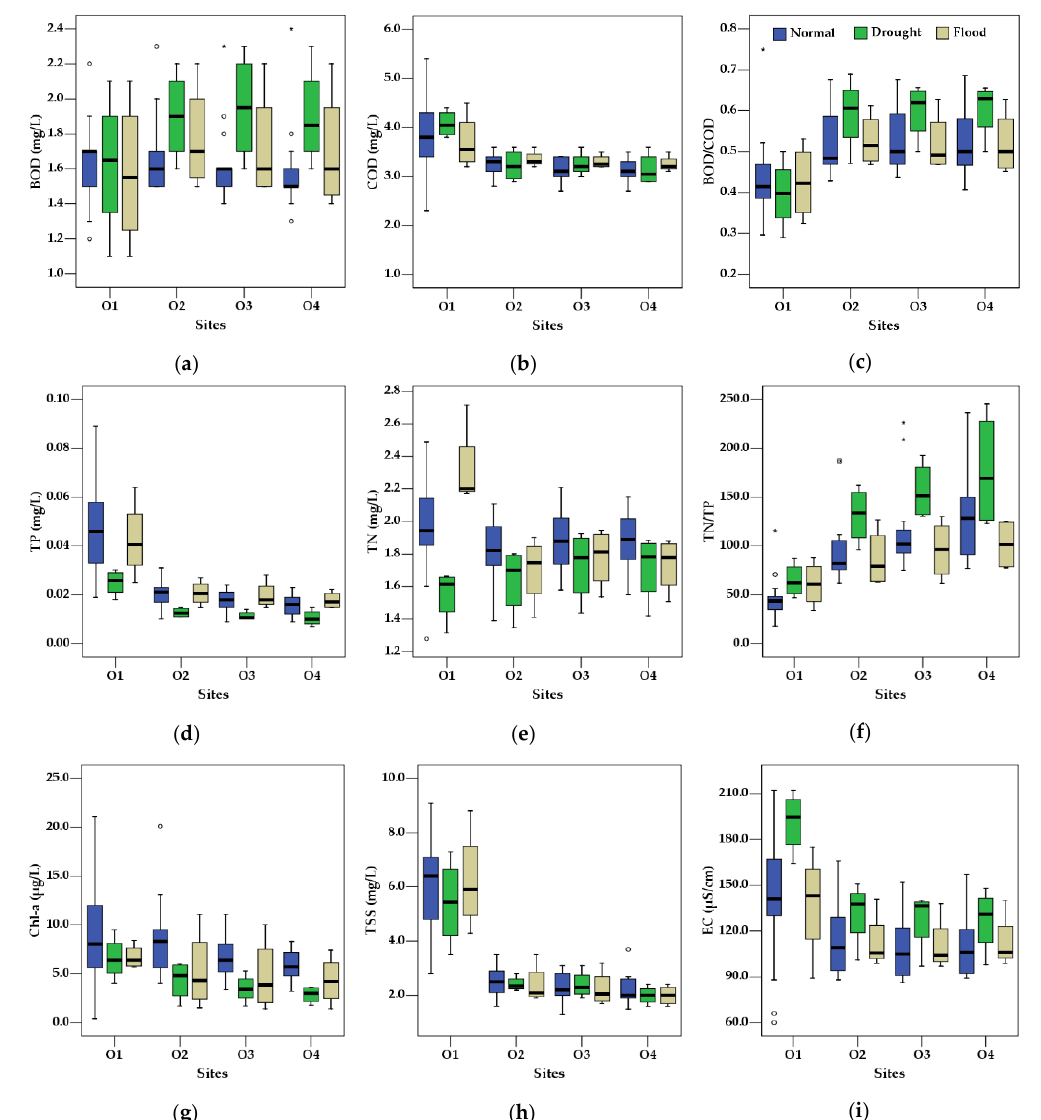
Figure 5. Spatial variations of water quality parameters in the study area: ( a ) BOD, ( b ) COD, ( c ) BOD/COD, ( d ) TP, ( e ) TN, ( f ) TN/TP, ( g ) Chl- a , ( h ) TSS, and ( i ) EC.